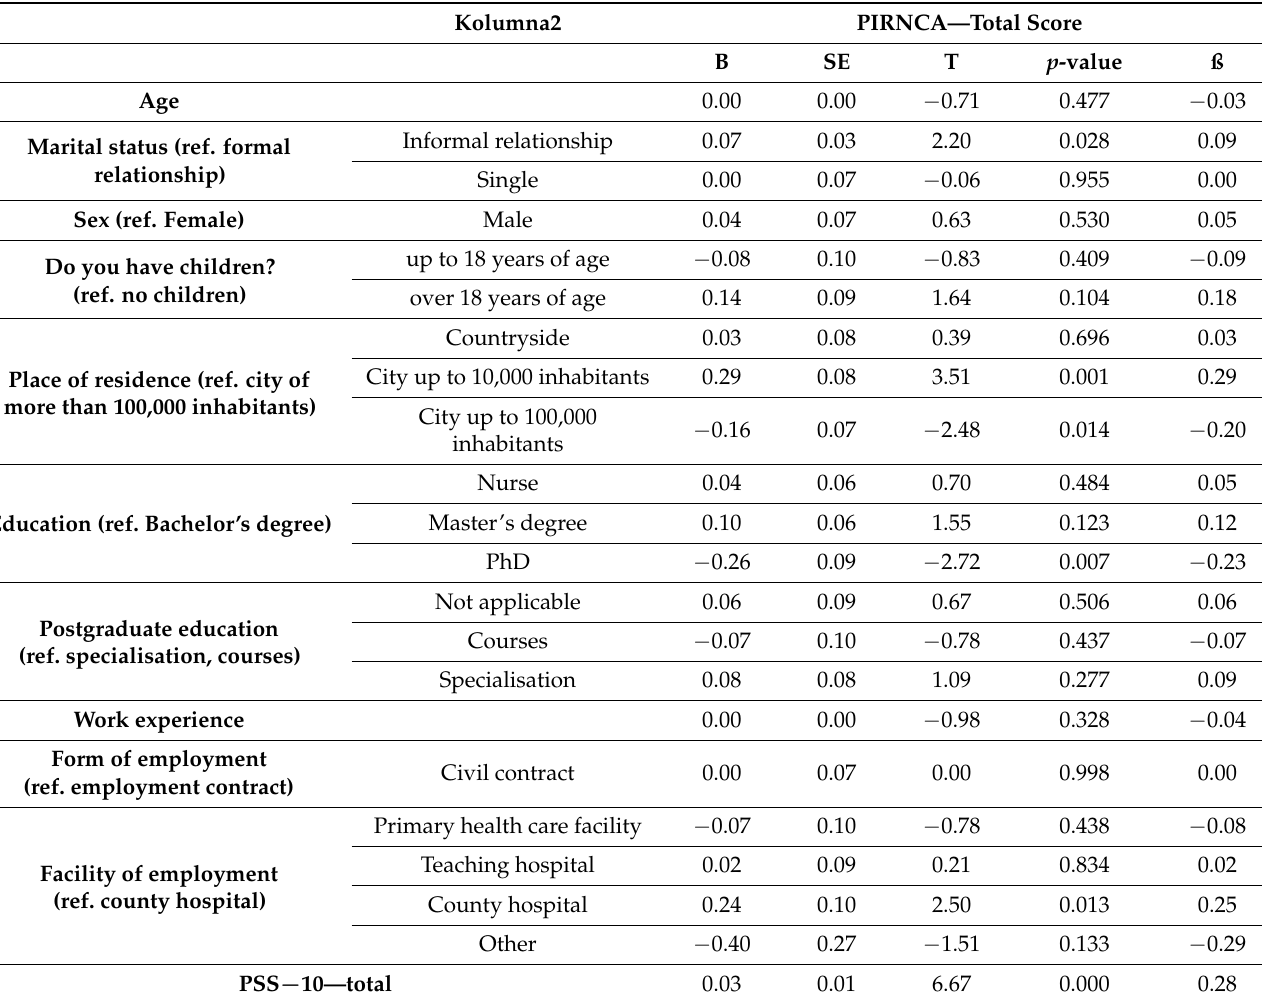
Table 6. Results of linear regression analysis of the effect of the selected variables on the level of nursing care rationing (PIRNCA). Kolumna2 PIRNCA—Total Score B SE T p